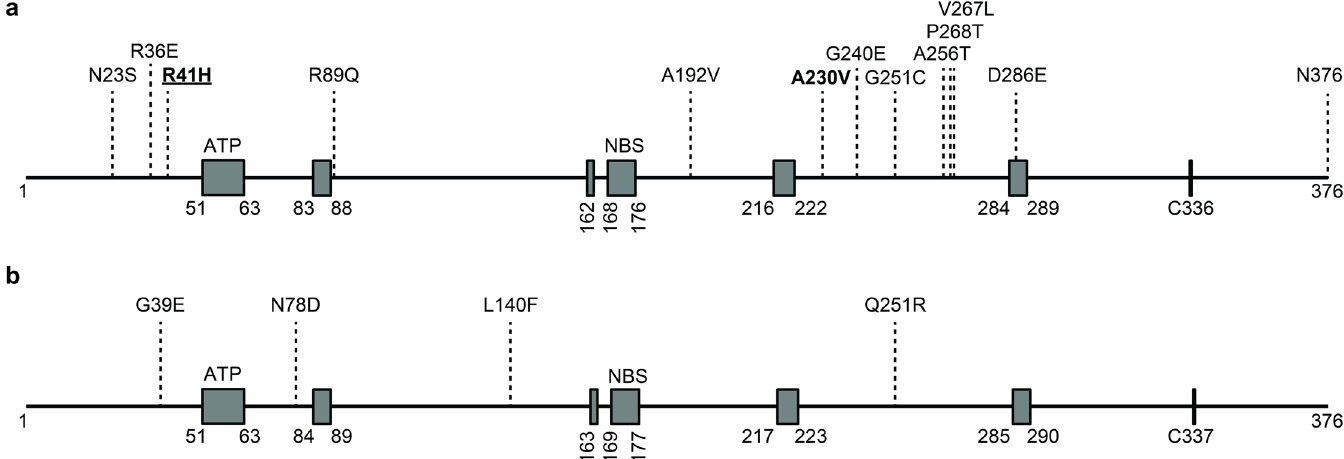
Fig 1. Location of identified amino acid substitutions in HSV thymidine kinase. Schematic representation of all identified amino acid substitutions in the thymidine kinase (TK) proteins of intrathecal HSV-1 ( A ) and HSV-2 ( B ) isolates obtained from herpes simplex encephalitis patients. Note that except for the D286E mutation in HSV-1 all amino acid substitutions are located outside of the functional domains of TK. Grey boxes depict highly conserved and functional domains, i.e. ATP-binding site (ATP), nucleotide binding sites (NBS) and a cysteine residue at position 336 and 337 for HSV-1 and HSV-2, respectively [31, 32]. TK amino acid locations are indicated according to HSV-1 reference strain 17 (GenBank accession number: JN555585.1) and HSV-2 reference strain HG52 (NCBI accession number: NC_001798.1). Regular font: natural polymorphisms; bold : new mutation; bold and underlined : mutation with unclear significance for ACV